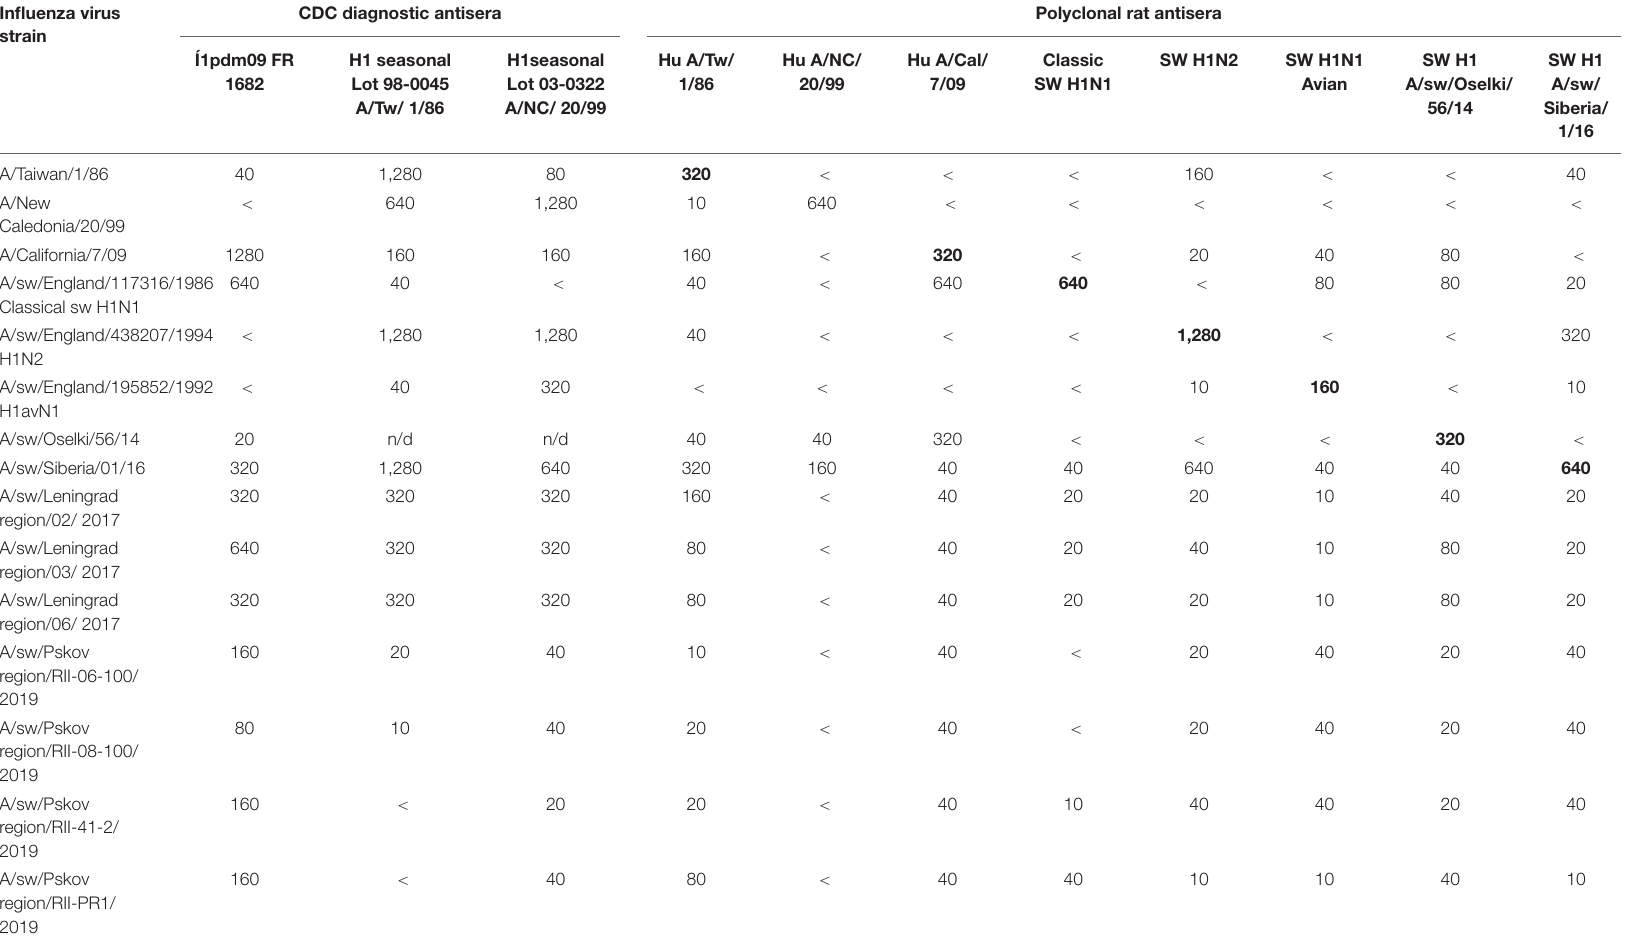
The homologous titres of the reference antisera are indicated in